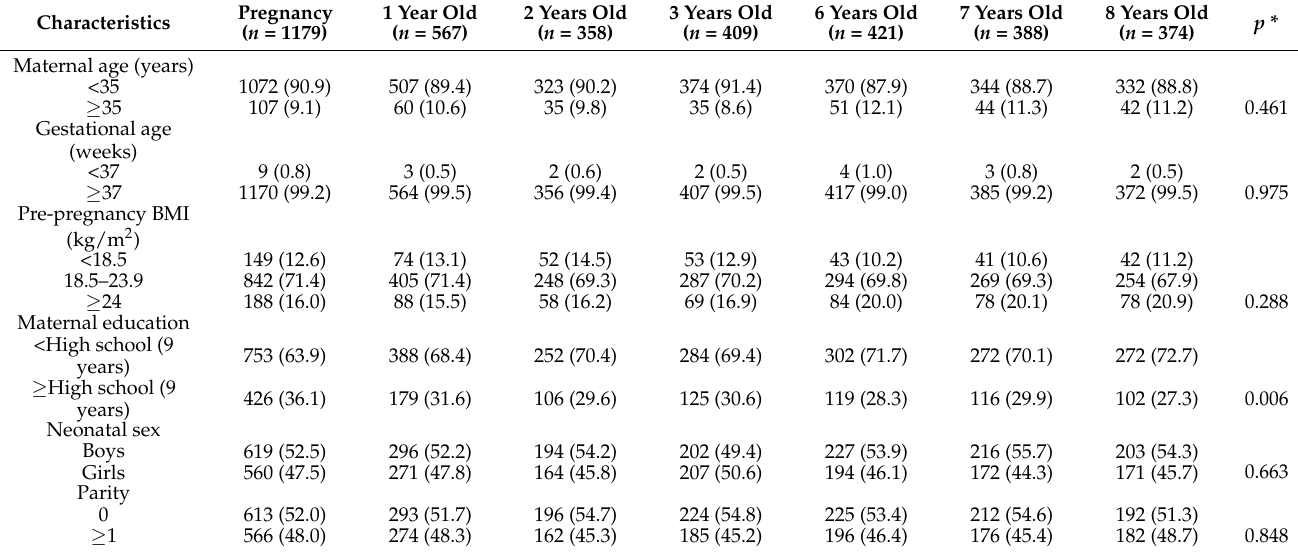
Table 1. Maternal characteristics and sociodemographic characteristics in each subgroup. ( N (%)).